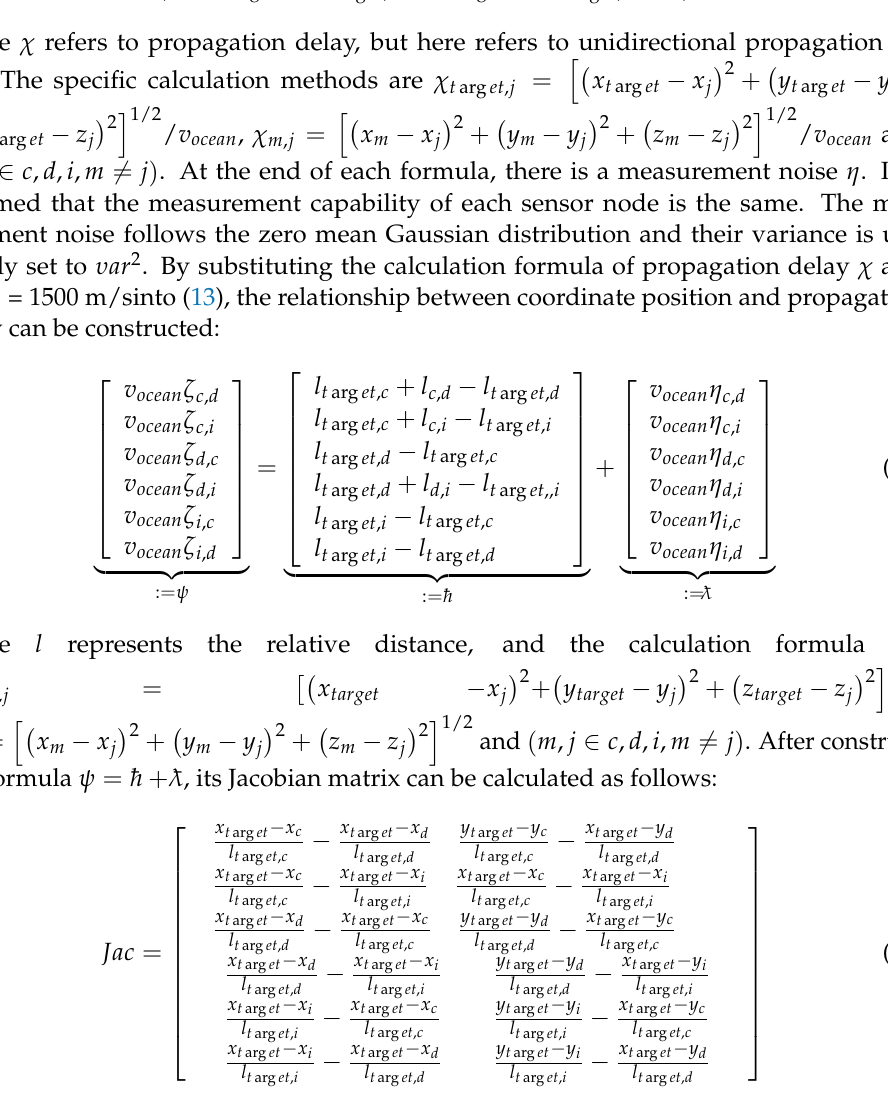
( c ) Figure 7. Training images. (a) Positive image. (b) Negative image. (c) Negative image. After the data set required for basic training is prepared, the quantity and type of 313 data are still insufficient. Here, the data enhancement technology is introduced, and the 314 processing methods include gray adjustment, horizontal/vertical flipping, angle conversion 315 and size adjustment of the existing image. The program automatically divides the spectrum 316 into multiple small blocks, and each small block is saved as an image in PNG format. 317 There are two folders for saving images, one named "YES" and the other named "NO". 318 The application of data enhancement technology is also mainly aimed at the images in the 319 folder "YES". In order to distinguish them, different names are used. The specific training 320 and experimental results are described in detail in the sixth part of this paper. 321 3.2. LA-AIC